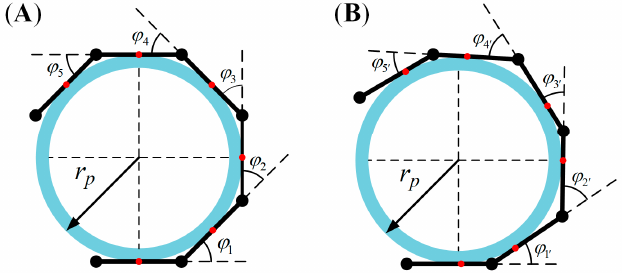
Figure 5. The contact models of a snake-like robot with the cylinder: ( A ) Central point contact model. ( B ) Non-central point contact model.